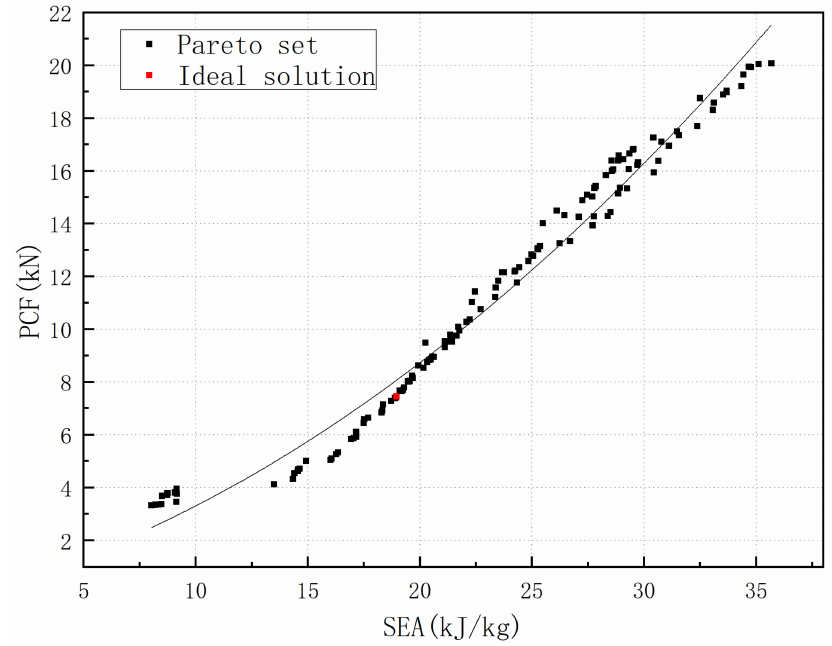
Figure 22. Pareto fronts from the surrogate model. The design objectives SEA, PCF, and mass are 22.196 kJ/kg, 7.433 kN, and 7.777 g, respectively. The values are S = 6.026 mm, h = 2.0 mm, b = 2.039 mm, and t = 0.501 mm for each optimization